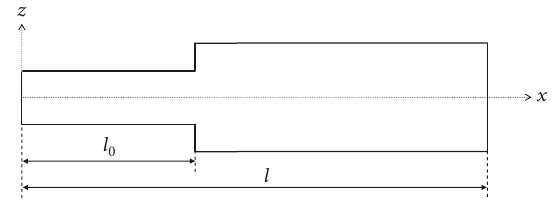
Figure 1: Stepped beam system